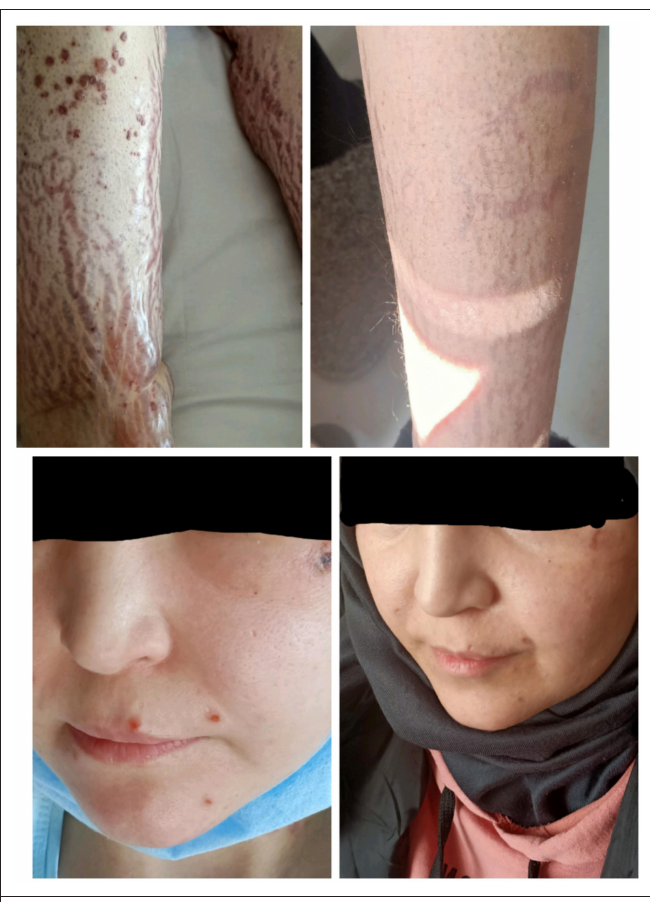
Figure 2. Skin lesions before and after four doses of cyclophosphamide